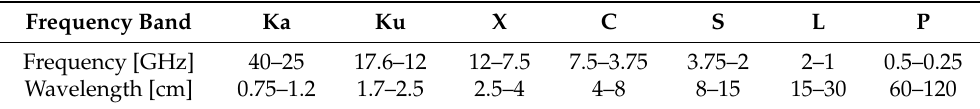
Table 1. Most used frequency bands in SAR and respective wavelengths